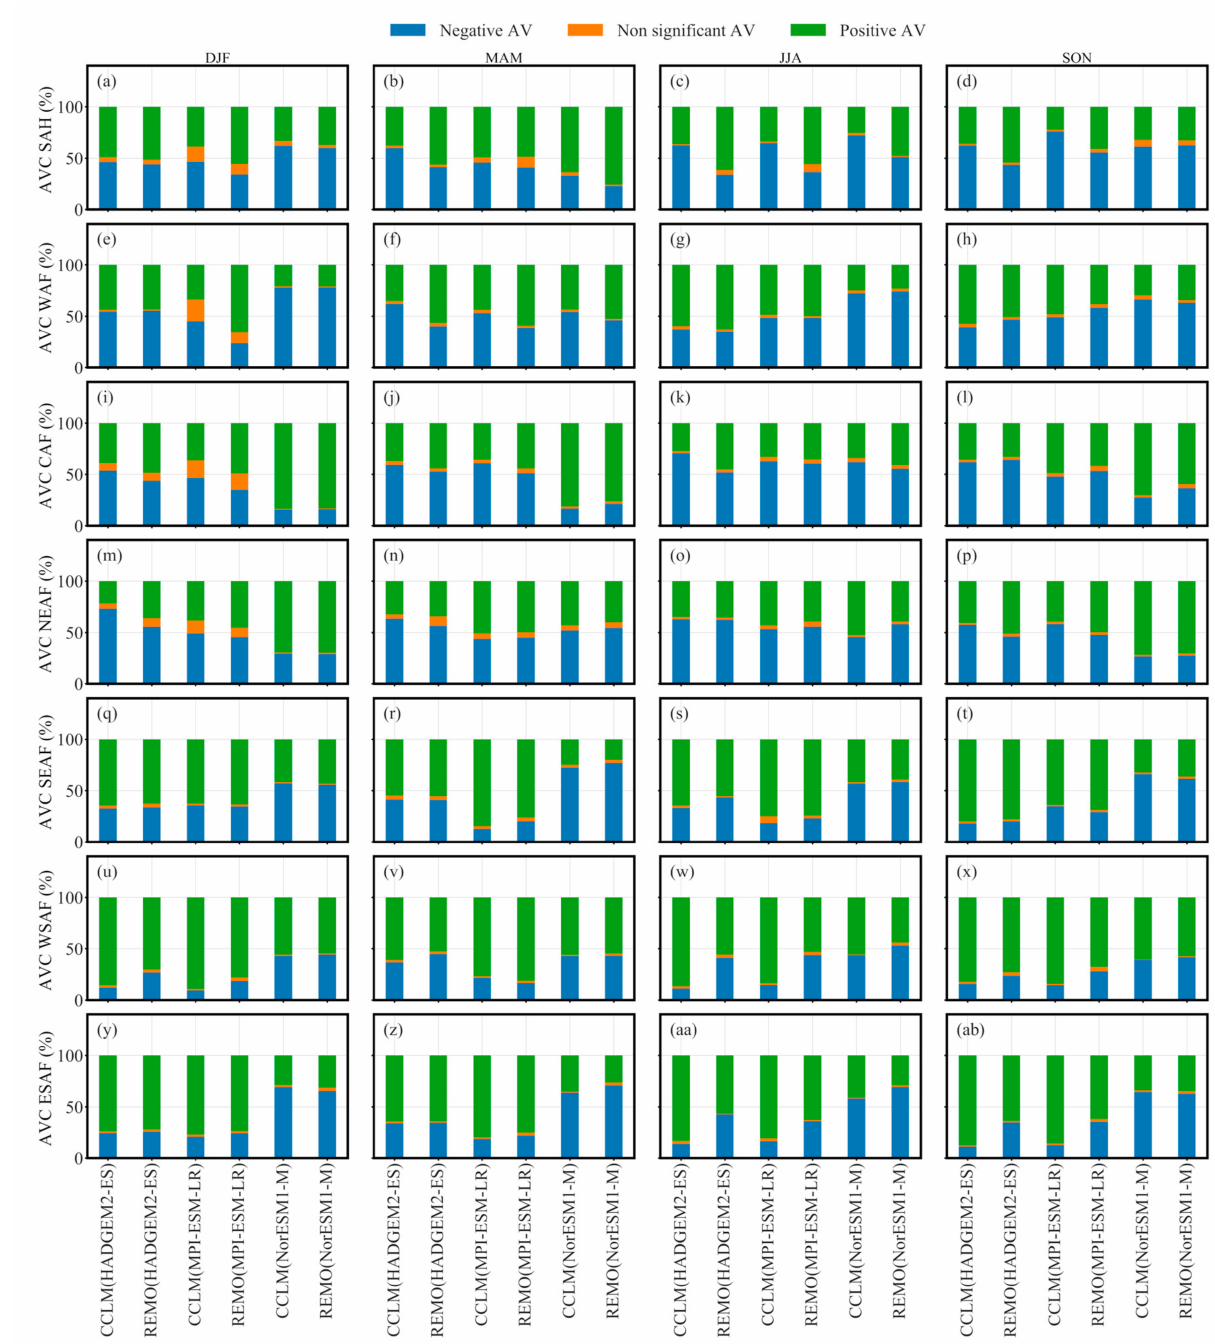
Figure 8. Added value coverage percentage per sub-region indicated in Figure 1 with GPCC as the observational